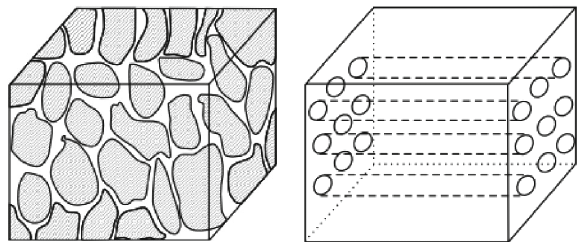
Figure 1: Capillary bundle model